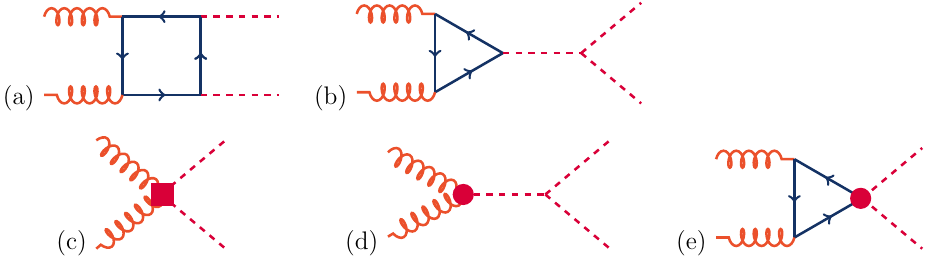
Figure 1 . Feynman diagrams that contribute to HH production via gluon-gluon fusion at LO. Diagrams (a) and (b) correspond to SM-like processes, while diagrams (c), (d), and (e) correspond to pure BSM e(cid:11)ects: (c) and (d) describe contact interactions between the Higgs boson and gluons, and (e) describes the contact interaction of two Higgs bosons with top